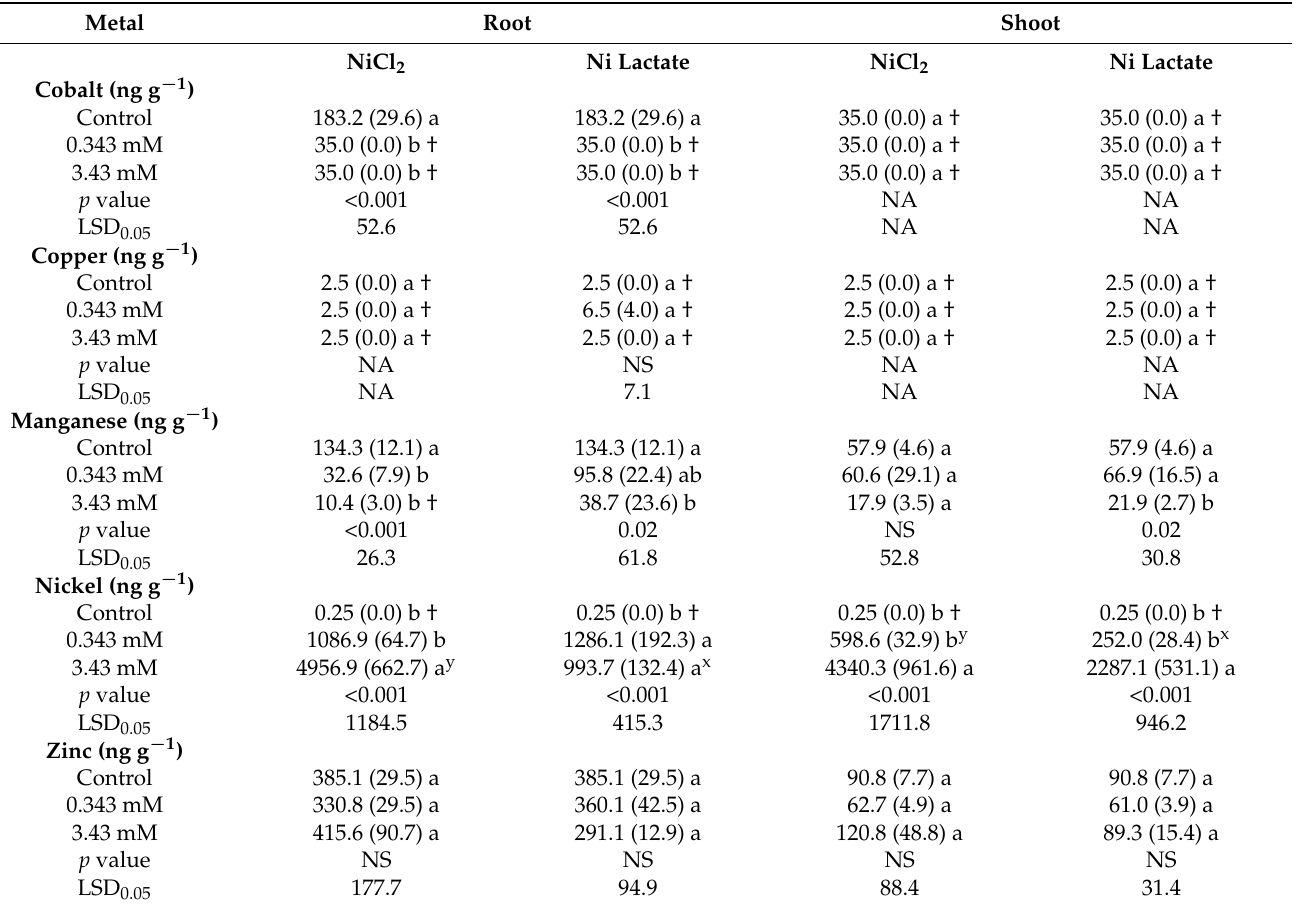
Table 8. Mean concentration of Co, Cu, Mn, Ni and Zn in the root and shoot tissues of wheat grown with nickel chloride or nickel lactate. Control samples did not receive any nickel supplementation. Different letters indicate a statistically significant difference between treatment concentrations and control ( p < 0.05; Fisher’s LSD Test). The “†” symbol indicates that the mean was derived from one or more replicates with metal concentrations below the instrument detection limit (DL) and were substituted with values equal to the DL/2. Superscripts “x” and “y” denote a significant difference between nickel chloride and nickel lactate at the specified concentration ( p < 0.05; simple t -test). Standard error is denoted in